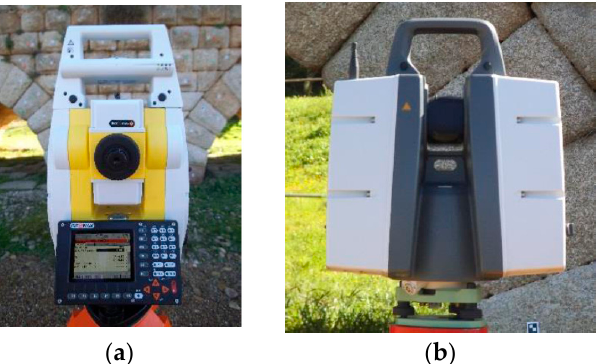
Figure 3. Used equipment: ( a ) Geomax Zoom 80 high precision Total Station; and ( b ) Leica ScanStation P30.